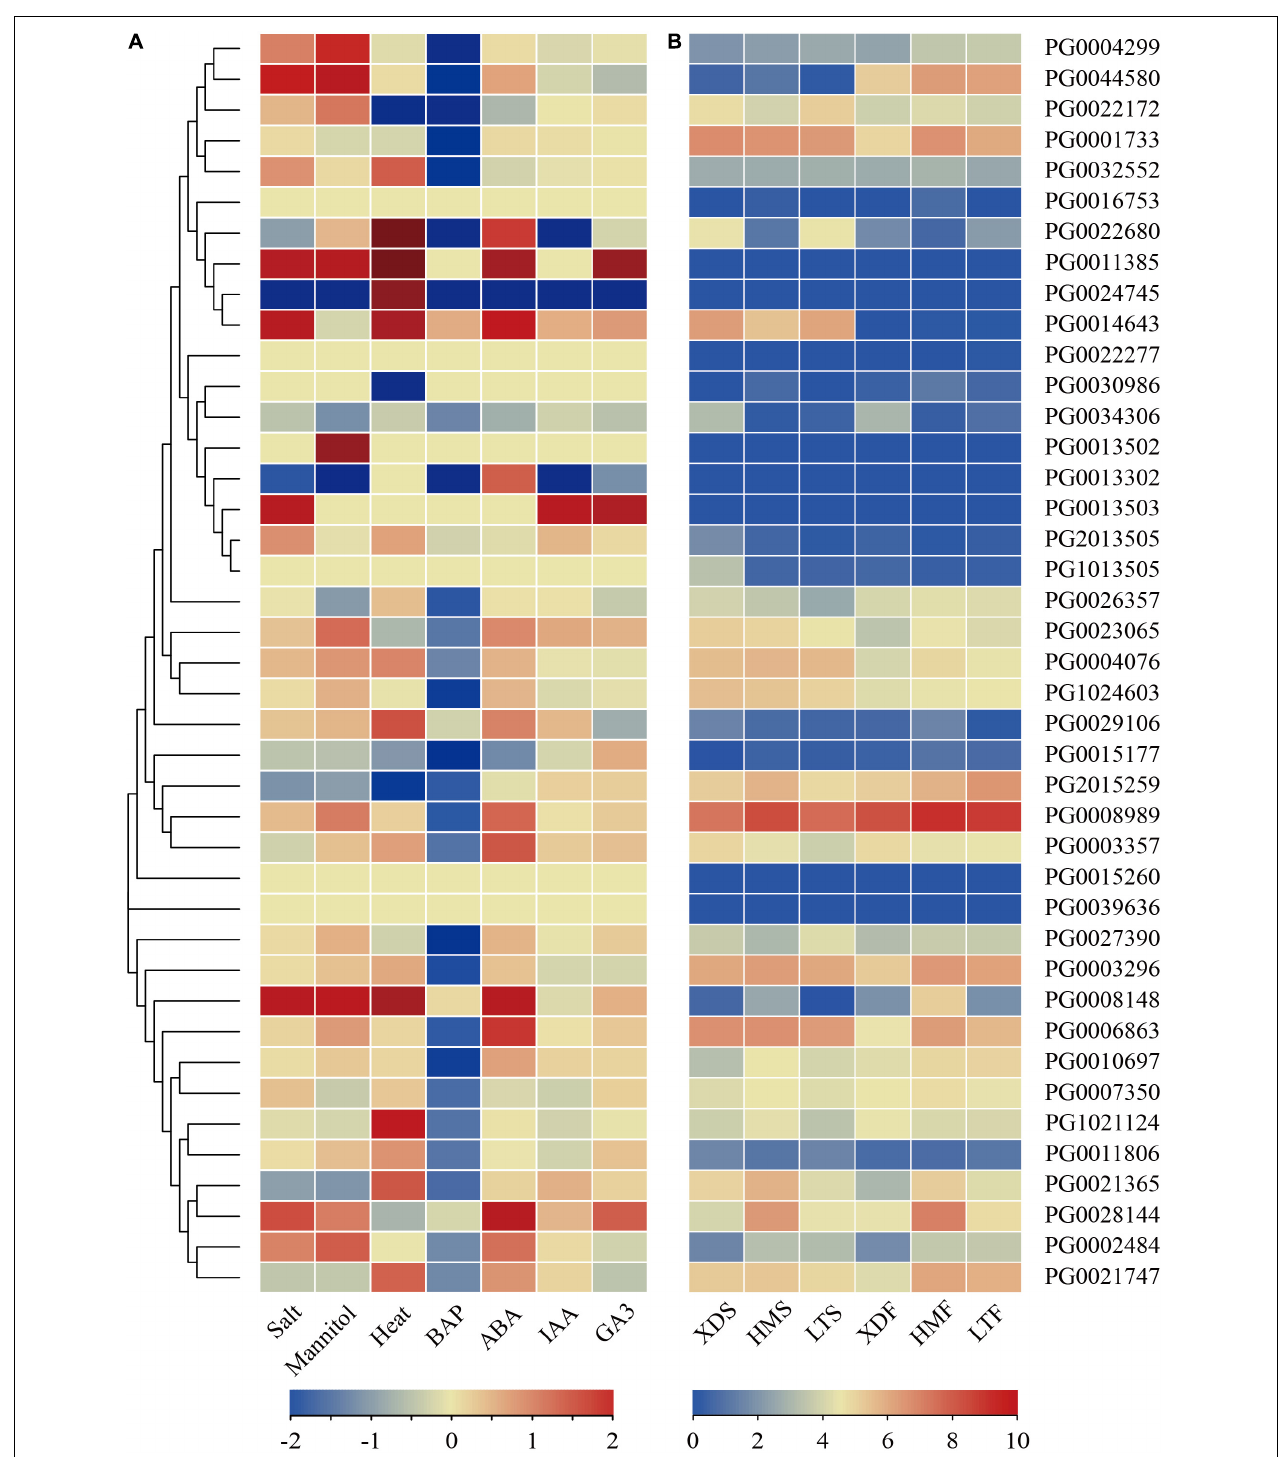
FIGURE 8 | The expression profiles of StNF-Y genes. (A) The expression profiles of StNF-Y genes under abiotic stresses (salt, mannitol, and heat stress) and hormone treatments (BAP, ABA, IAA, and GA3) in DM potato. The color scale was plotted using the log 2 FC of each gene. (B) The expression profiles of StNF-Y genes in white and pigmented potato tuber skin and flesh. XDS, LTS, HMS represent the white skin of white potato cultivar (Xindaping, XD), the red skin of red potato cultivar (Lingtianhongmei, LT), and the purple skin of purple potato cultivar (Heimeiren, HM), respectively. XDF, LTF, and HMF represent the white flesh of XD, the red flesh of LT, and the purple flesh of HM, respectively. The color in the heat map represents the FPKM value using logarithm with a base of 2. The heatmap was constructed by TBtools software. BAP, benzylaminopurine; ABA, abscisic acid; IAA, indole acetic acid; GA3, gibberellic acid.